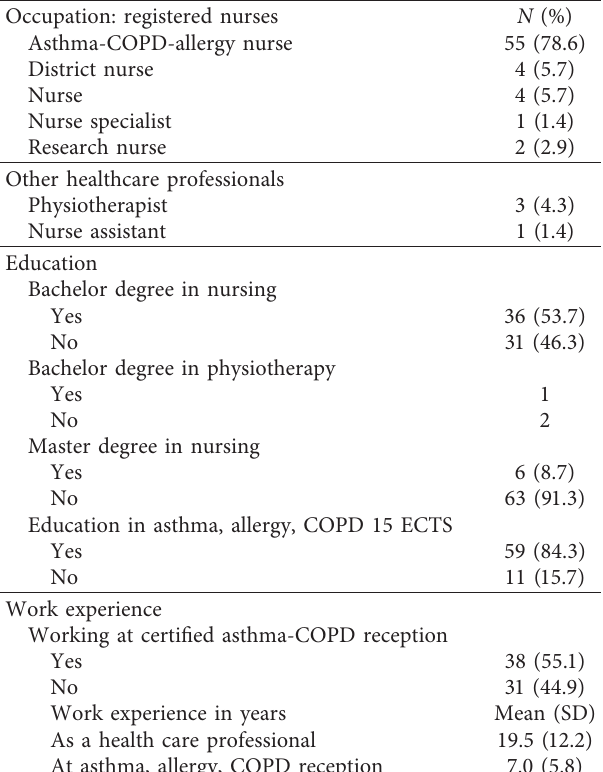
Table 2: Background characteristics of the study population ( n �